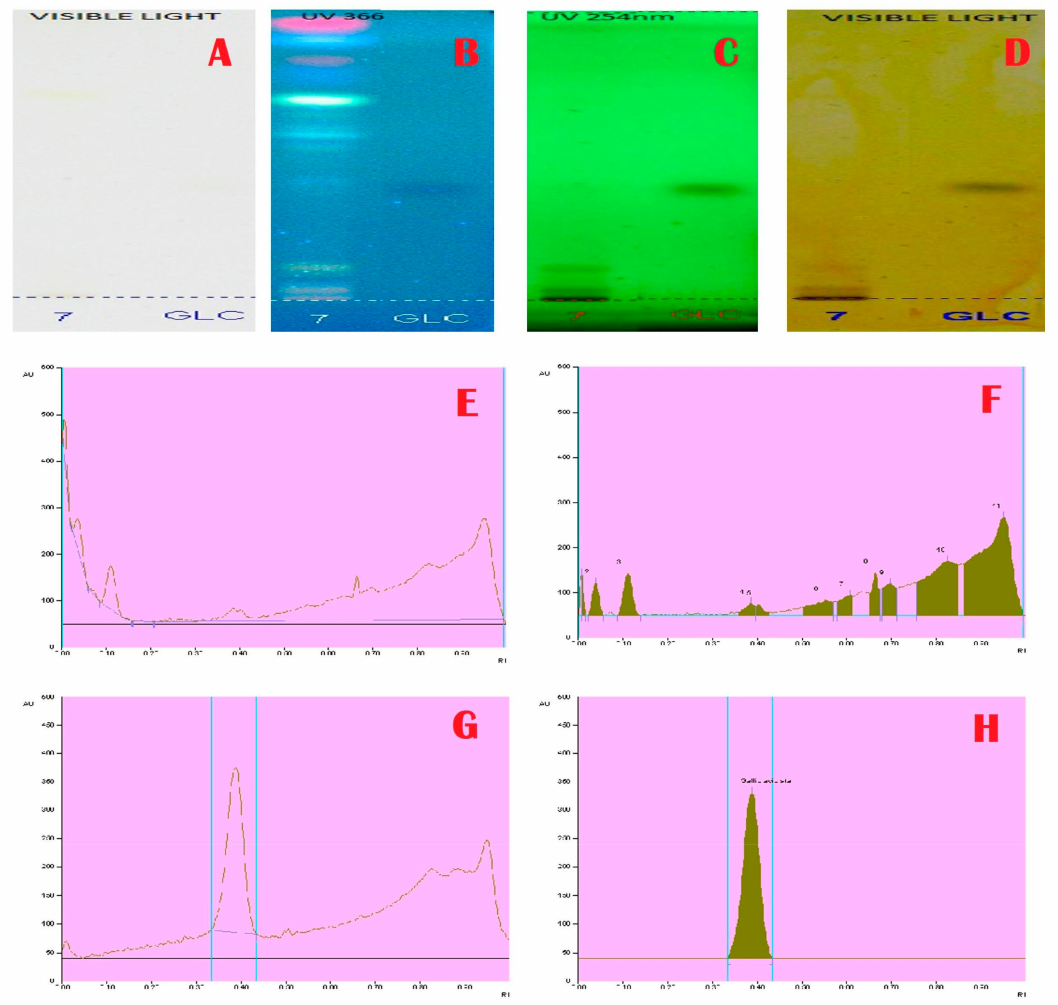
Figure 4. Tannins Profile and Chromatogram of A. aethiopicum. ( A ): HPTLC profile of A. aethiopicum under visible light; ( B ): HPTLC profile of A. aethiopicum under UV light at 366 nm before derivatization; ( C ): HPTLC profile of A. aethiopicum under UV light at 234 nm before derivatization; ( D ): HPTLC profile of A. aethiopicum under visible light after derivatization; ( E ): HPTLC chromatogram of ethanolic extracts of A. aethiopicum —base line display scanned at 254 nm; ( F ): HPTLC chromatogram of ethanolic extracts of A. aethiopicum —peak densitogram display scanned at 254 nm; ( G ): HPTLC profile of standard Gallic acid—peak baseline display scanned at 254 nm; ( H ): HPTLC chromatogram of standard Gallic acid—peak densitogram display scanned at 254